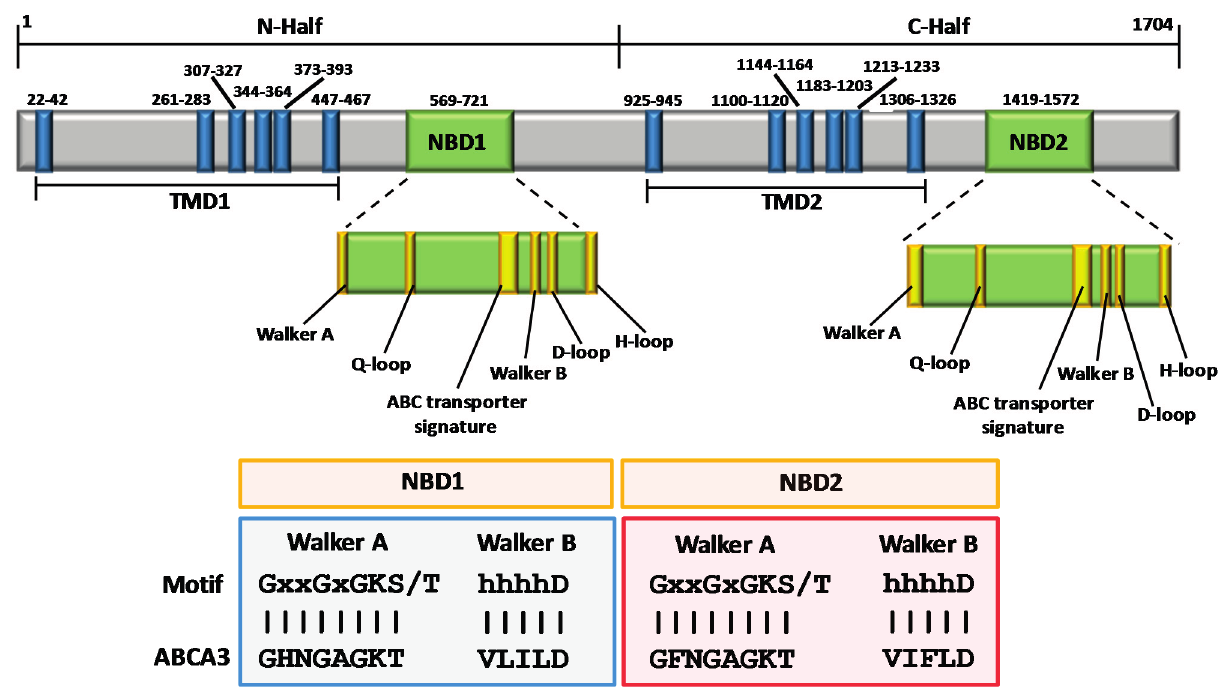
Figure 1. Schematic representation of ABCA3 protein with domains indicated in blue ( α -helices) and green (NBDs). The N- and C-half have been indicated and the motif sequences of Walker A and B for NBD1 and NBD2 have been reported and compared to that of ABCA3. ABCA3: adenosine triphosphate (ATP)-binding cassette A3 transporter; NBD: nucleotide-binding domains; TMD: transmembrane